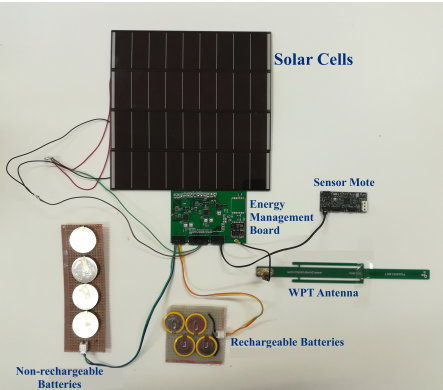
Figure 10. Lab setup for experiments. Energy management board, sensor mote, solar cells, rechargeable batteries and non-rechargeable batteries.